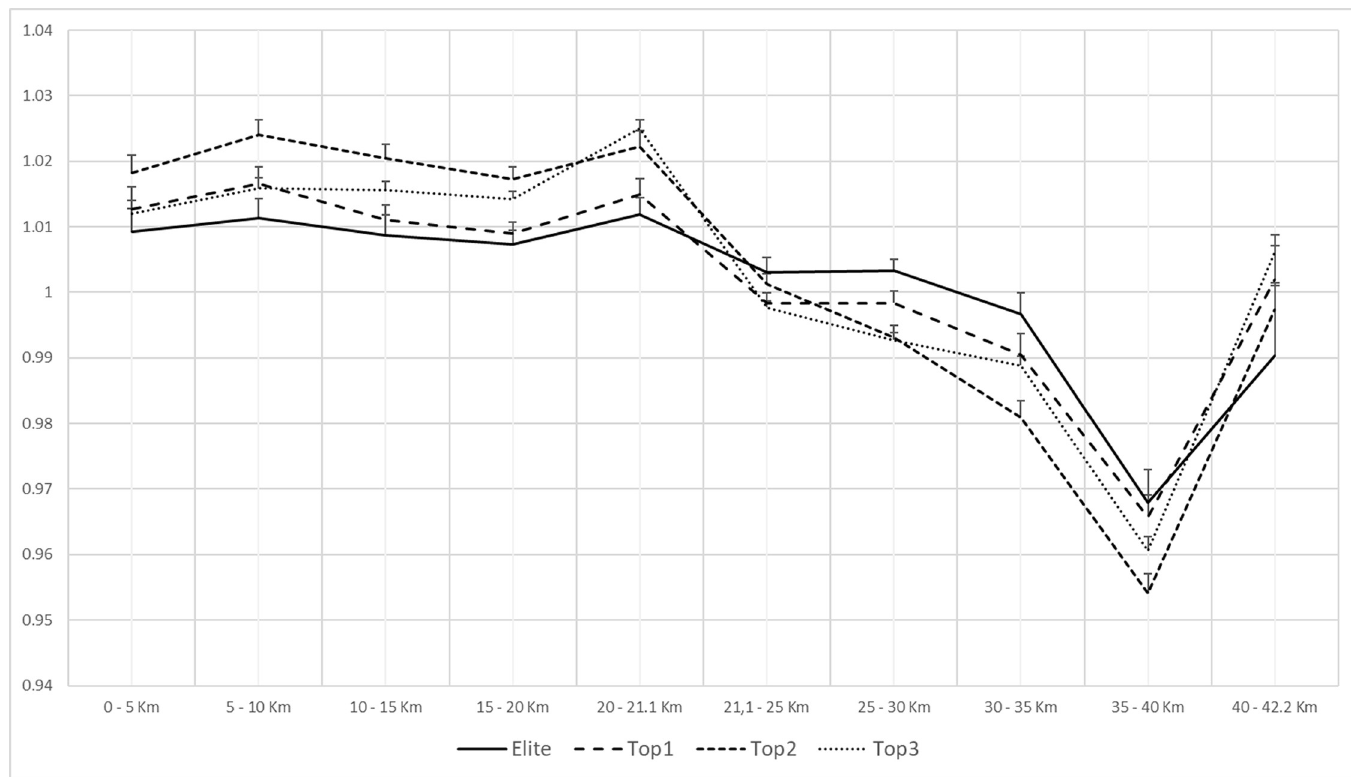
Fig 2. Paired profiles of average pace per split and group for women.